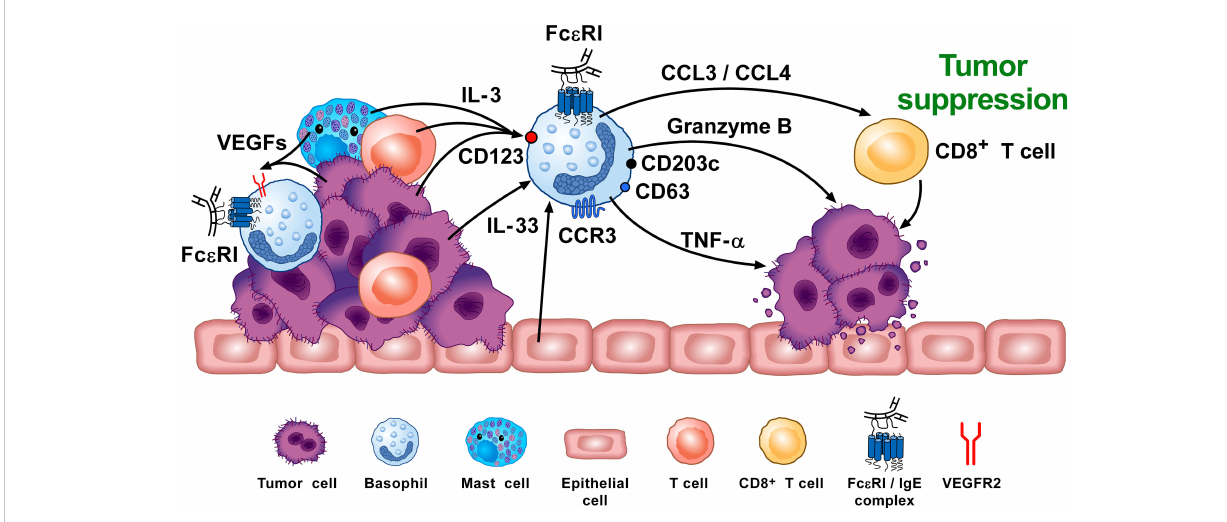
FIGURE 4 Basophils can promote tumor suppression through different mechanisms. Vascular endothelial growth factors (VEGFs) released by tumor and immune cells in the TME (e.g., macrophages, mast cells) (155 – 159) induce basophil recruitment via the activation of VEGFR2 on these cells (155). IL-3, released from intratumoral lymphocytes, mast cells and tumor cells (10, 160, 161), is the major growth, differentiation, priming and activating factor for both human and mouse basophils via the activation of the IL-3 receptor (IL-3R a /CD123) (8 – 10). Intratumoral basophils secrete CCL3 and CCL4 which favor CD8 + T cell in fi ltration in TME, favoring melanoma rejection in mice (75). IL-33 produced by epithelial and tumor cells, plays a critical role in tumorigenesis (162) by upregulating granzyme B mRNA and the surface expression of CD63 in basophils. Mouse basophils activated by IL-33 cause melanoma cell death in vitro (142). Mouse (104, 163) and, in certain conditions, human basophils (164, 165) release TNF- a and granzyme B (142, 166), which exerts cytotoxic activity on cancer cells (102, 167). Tumor resident basophils overexpressing CD123, CCR3, CD63, CD203c mRNAs are associated with improved outcome in ovarian cancer (88, 154). These fi ndings indicate that, under speci fi c experimental and clinical circumstances, basophils can play an anti-tumorigenic role. Adapted from Poto et al.